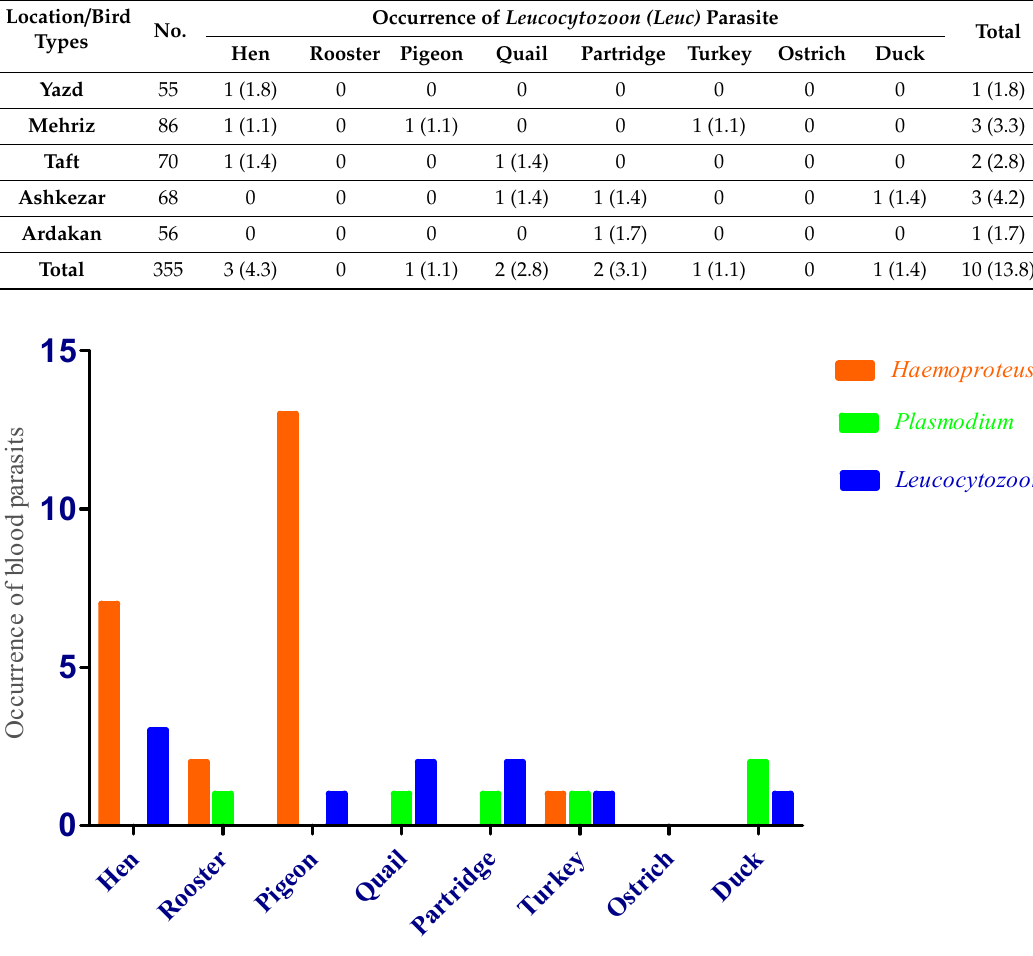
Figure 2. Estimated prevalence of blood parasites ( Haemoproteus, Plasmodium and Leucocytozoon ) infecting eight species of birds.